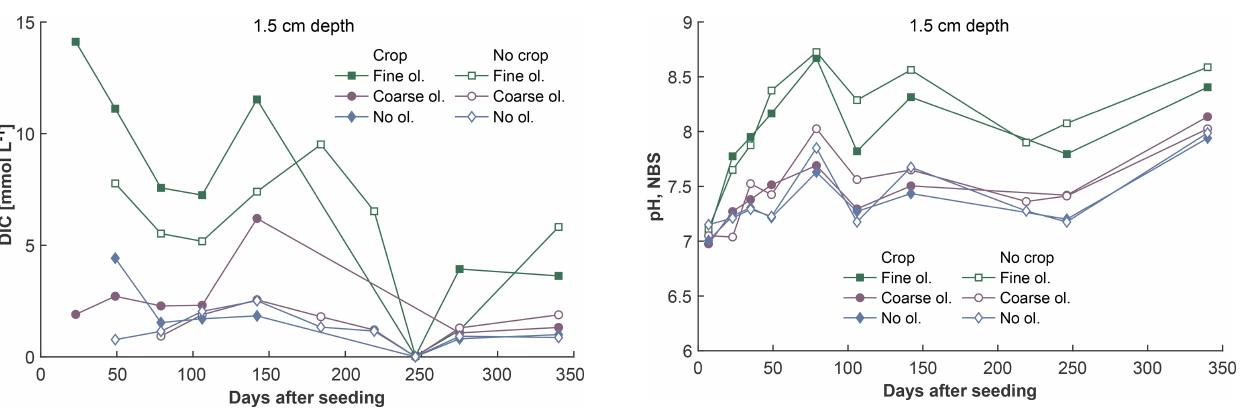
Figure 3. Development of average DIC concentrations over 1 year at 1.5cm depth, differentiated by olivine and crop treatment. For more information on the subsequent layers and error bars, please refer to Fig. S3-1 in the Supplement.